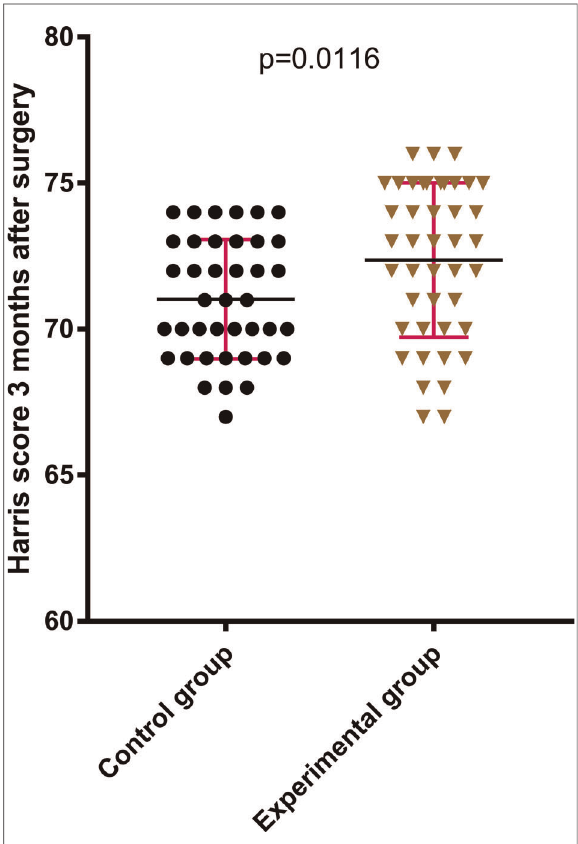
FIGURE 4 The Harris score of the hip joint at 3 months after operation in the experimental group is better than that in the control